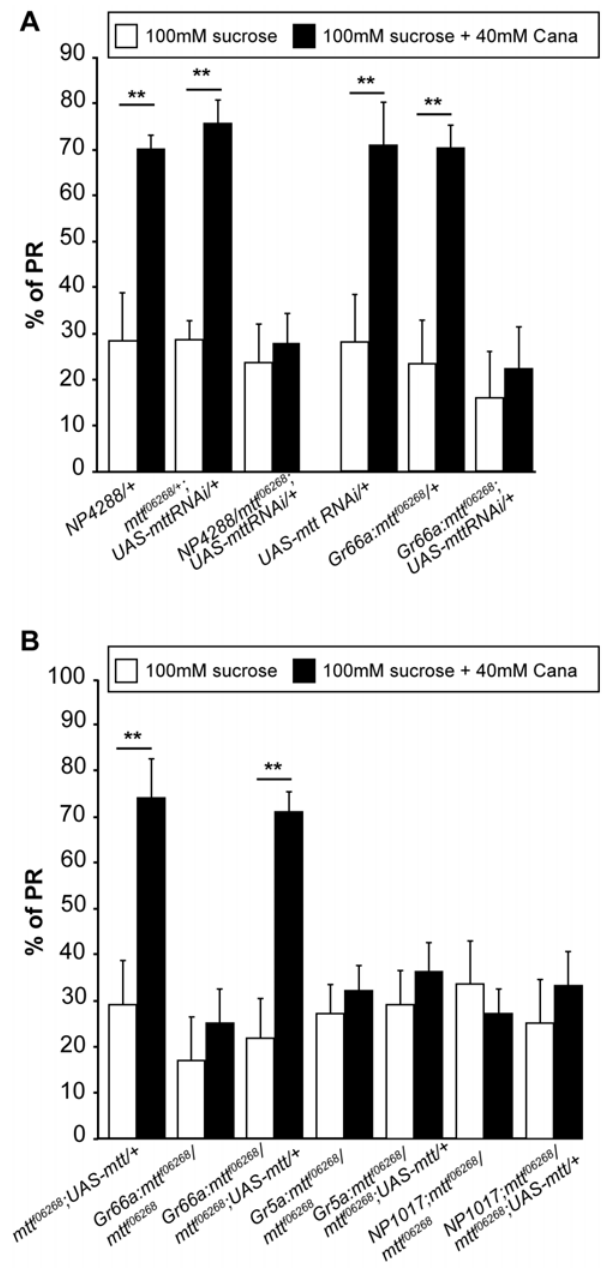
Figure 7. mtt is required in Gr66a-GRNs. (A) Knockdown of mtt expression by RNAi in NP4288-GRNs and Gr66a-GRNs suppresses the L - canavanine (Cana)-induced PR gustatory phenotype. Histograms show the percentage of PR of controls ( NP4288/ + , mtt f06268 / + ;UAS-mtt RNAi/ + , UAS-mtt RNAi/ + , and Gr66a:mtt f06268 / + ) and mtt heterozygous flies expressing the mtt RNAi construct in NP4288-positive GRNs ( NP4288/ mtt f06268 ;UAS-mtt RNAi/ + ) or in Gr66a-GRNs ( Gr66a:mtt f06268 ;UAS-mtt RNAi/ + ). Compared to controls, the down-regulation of mtt in NP4288- GRNs or in Gr66a-GRNs suppresses the L -canavanine–induced PR. For all genotypes, L -canavanine does not significantly affect the percentage of PER (see Figure S4A). Behavioral analyses were performed as described in Figure 6. Error bars indicate SEM. Double asterisks indicate significant differences by t -test ( p , 0.001). (B) Expression of mtt in bitter-sensitive Gr66a-GRNs rescues the PR mutant gustatory phenotype of mtt mutant flies. Histograms show the percentage of PR of control flies ( mtt f06268 / + ;UAS-mtt/ + ), mtt mutant flies carrying one copy of each GRN